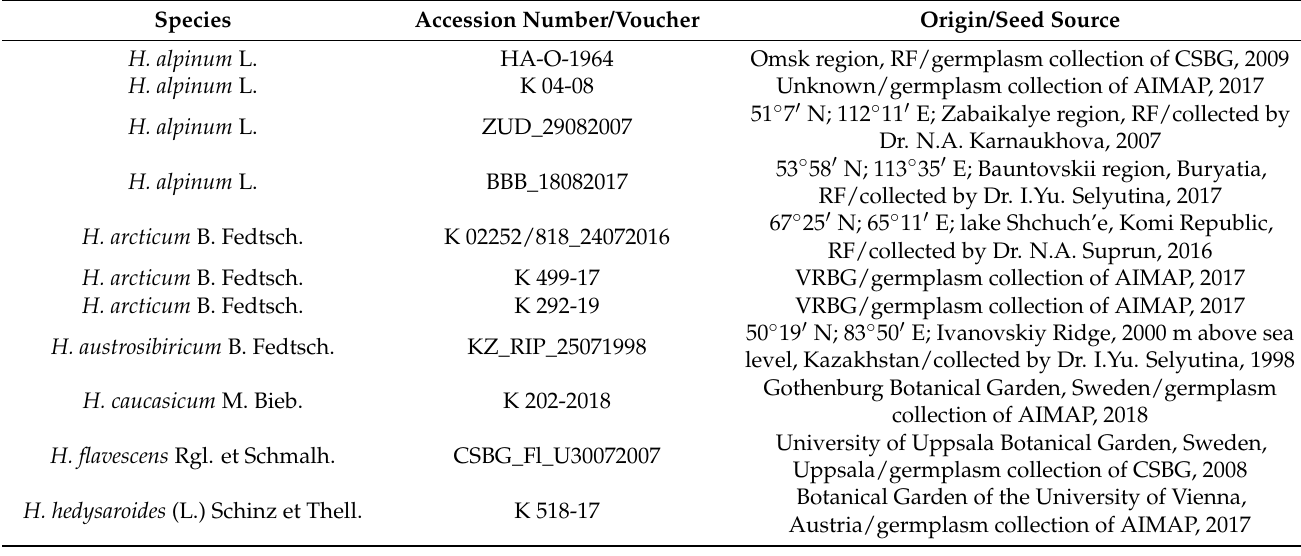
Table 1. The list of the studied plant